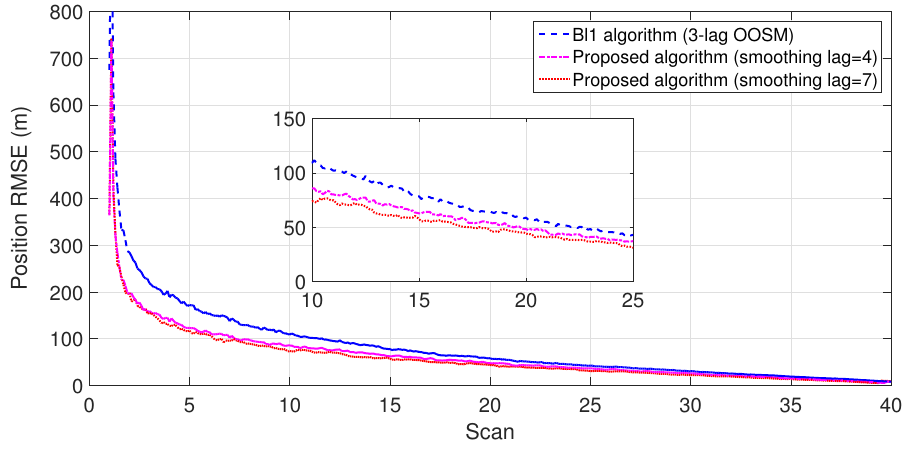
Figure 12. RMSE in position estimate for one-lag OOSM.